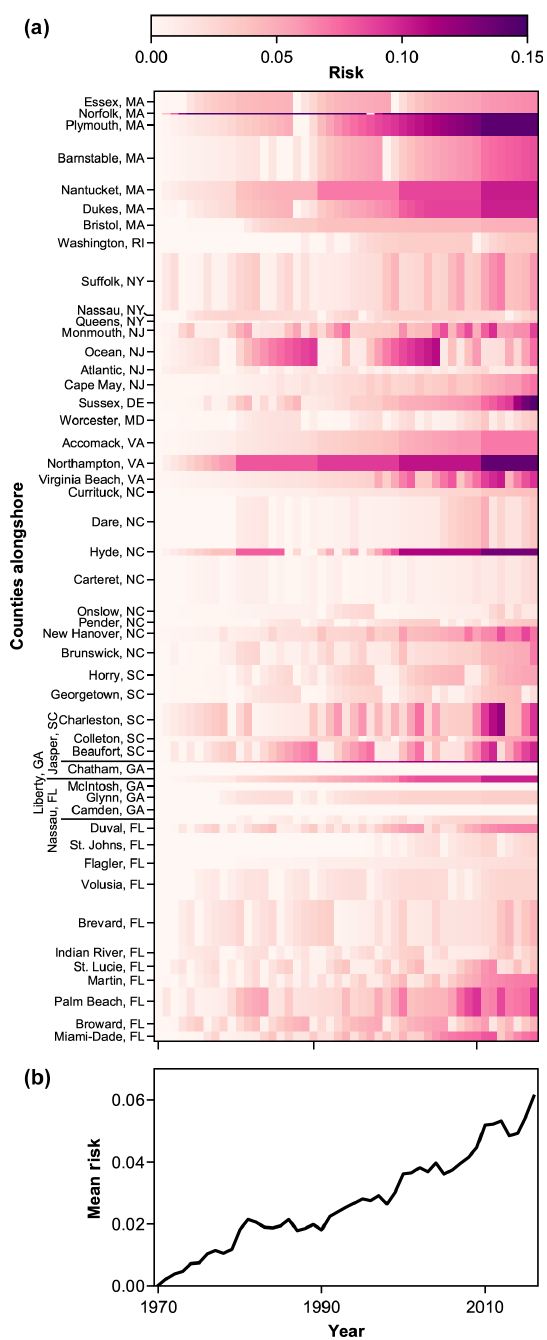
Figure 1. Evolution of (a) county-level risk (a function of hazard, exposure, and vulnerability) modelled for the US Atlantic coast, from 1970 to 2016. Hazard in this simulation reflects historical ero- sion rates. For visualization and analysis, each county is scaled by the number of 1km transects it comprises. The result is a matrix of 2386km over 47 years, in which each of the 2386 (1km) rows is associated with a county. Note that risk in Norfolk County, MA, ex- ceeds the maximum scale bar value of 0.15 (2016 risk = 0.418; see Table 1). (b) Alongshore mean values through time for the whole US Atlantic coast are taken from the full matrix (a) , reflecting the relative alongshore scale of each